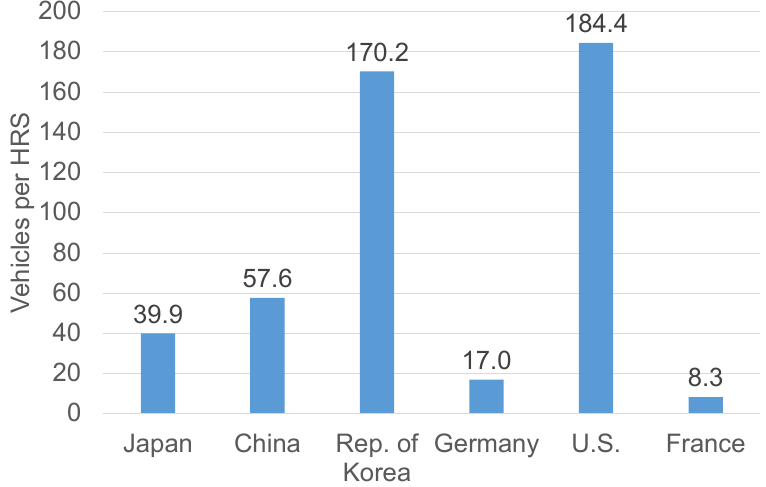
Figure 14. FCVs per station in the top six countries, with more than 50 stations in operation as of the end of 2021.